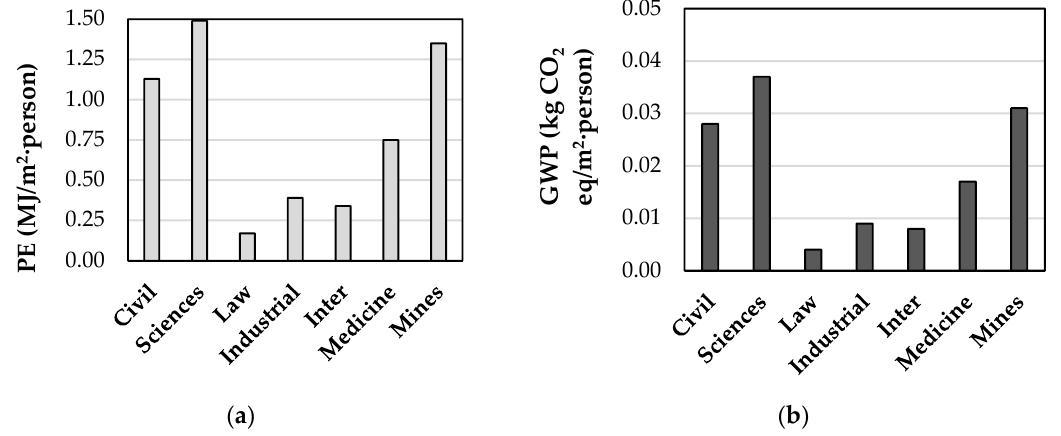
Figure 10. Contribution of the different buildings: ( a ) total primary energy (PE); ( b ) global warming potential (GWP).